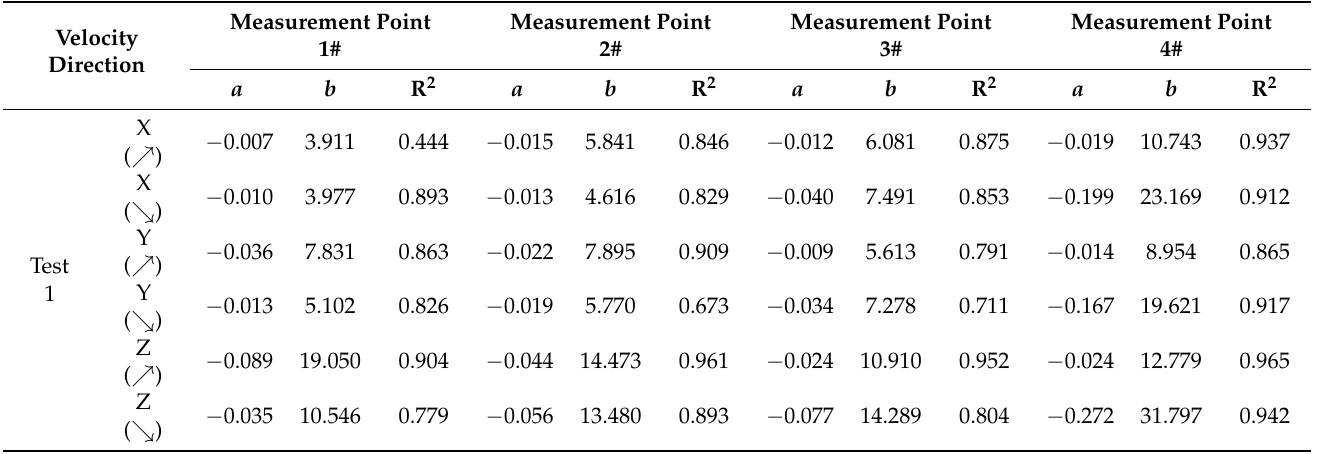
Table 2. Linear regression coefficients and R 2